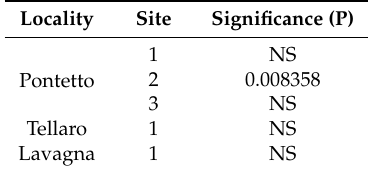
Table 3. T -test results for Pontetto, Tellaro, and Lavagna localities and